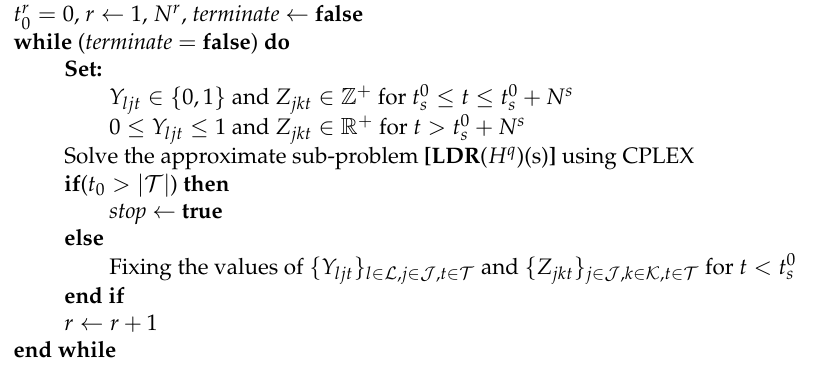
Algorithm 2 Rolling Horizon (RH)